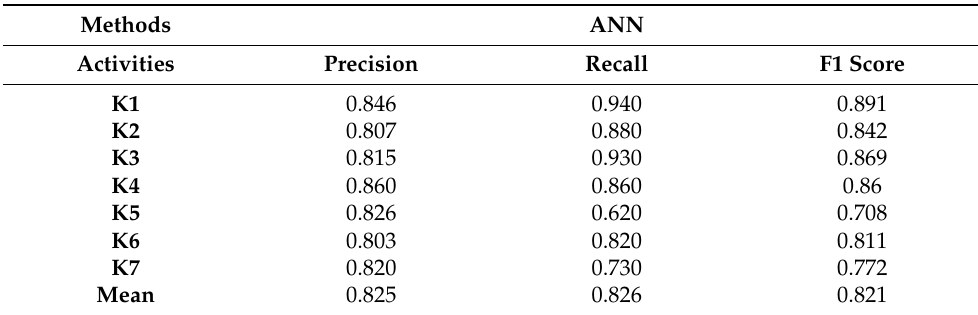
Table 3. Comparison of the evaluation metrics (precision, recall, and F1 score) of the MTSM model from the KITTI dataset.